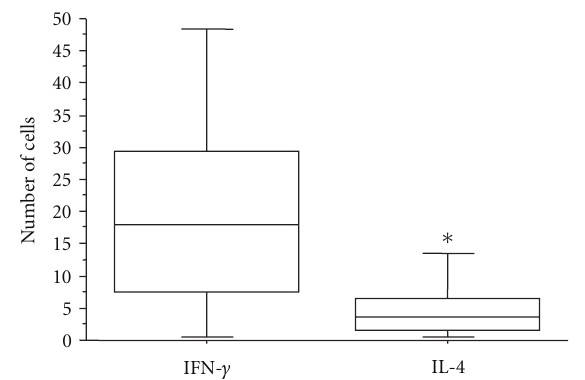
Figure 4: Number of IFN- γ - and IL-4-immunostained inflam- matory cells in 21 subjects with chronic chagasic cardiopathy. Horizontal lines represent the median, boxes represent the 25th to 75th percentiles, and vertical lines indicate the 10th to 90th percentiles. ∗ P < 0 . 05 (Mann-Whitney test).